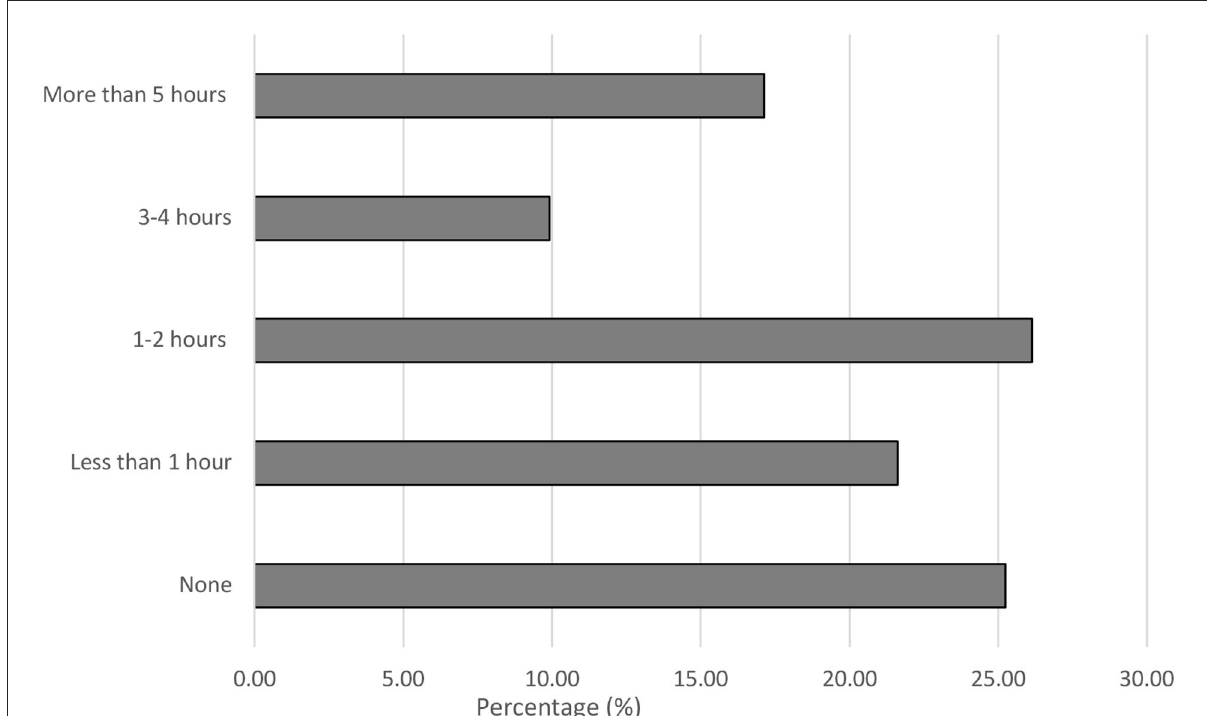
FIGURE1 Reported prior training received in LGBTQIA + healthcare. Participants ( n = 111) responded to the following Prompt: (P0) How much prior teaching have you received in your current program exclusive to the care of lesbian, gay, bisexual, and transgender (LGBTQIA + ) patients? Data is represented as a percentage of the total responses